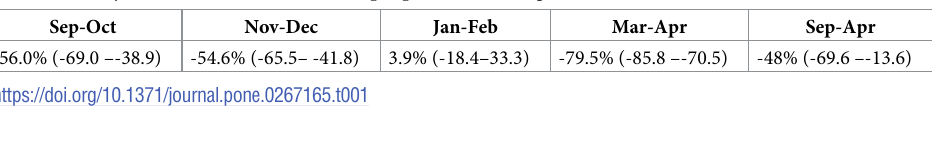
Table 1. Percent change (95% Crl) in predicted murrelet density between the first and last year surveyed for each 2-month survey window and for the entire (Sep-Apr) non-breeding season.